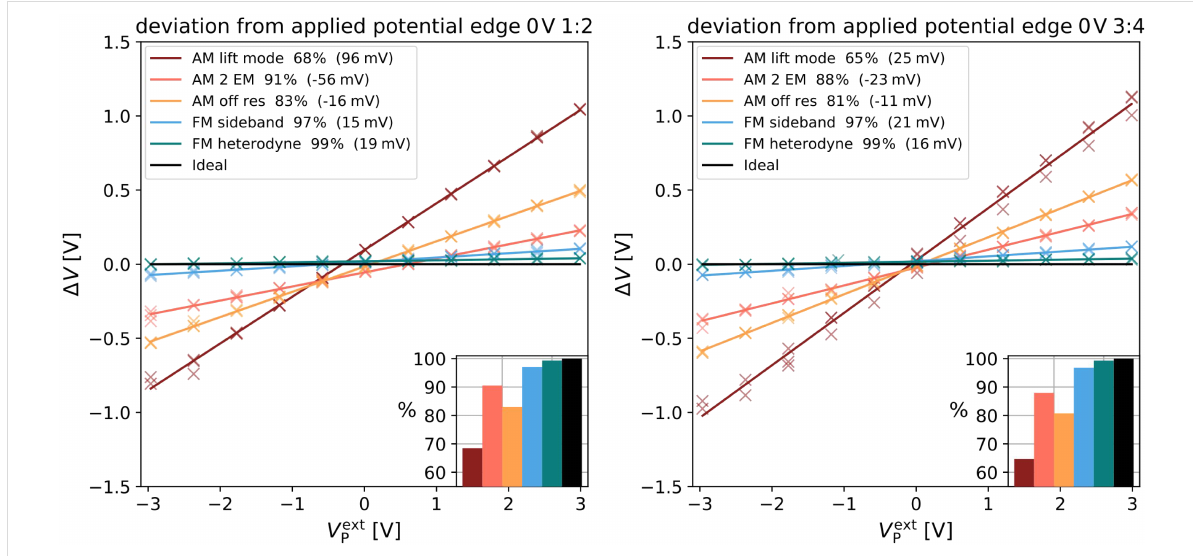
Figure 5: Comparison of the deviation of the measured potential difference from the applied potential plotted against the applied potential for AM (warm colors) and FM (cool colors), black represents an ideal measurement. Insert in the lower right visualizes the fraction of the potential captured by the respective method. Legend in the upper left shows the offset in brackets. Data shown captured on the electrodes 1/2 (left) and 3/4 (right) of the electrode structure without an additional electrostatic